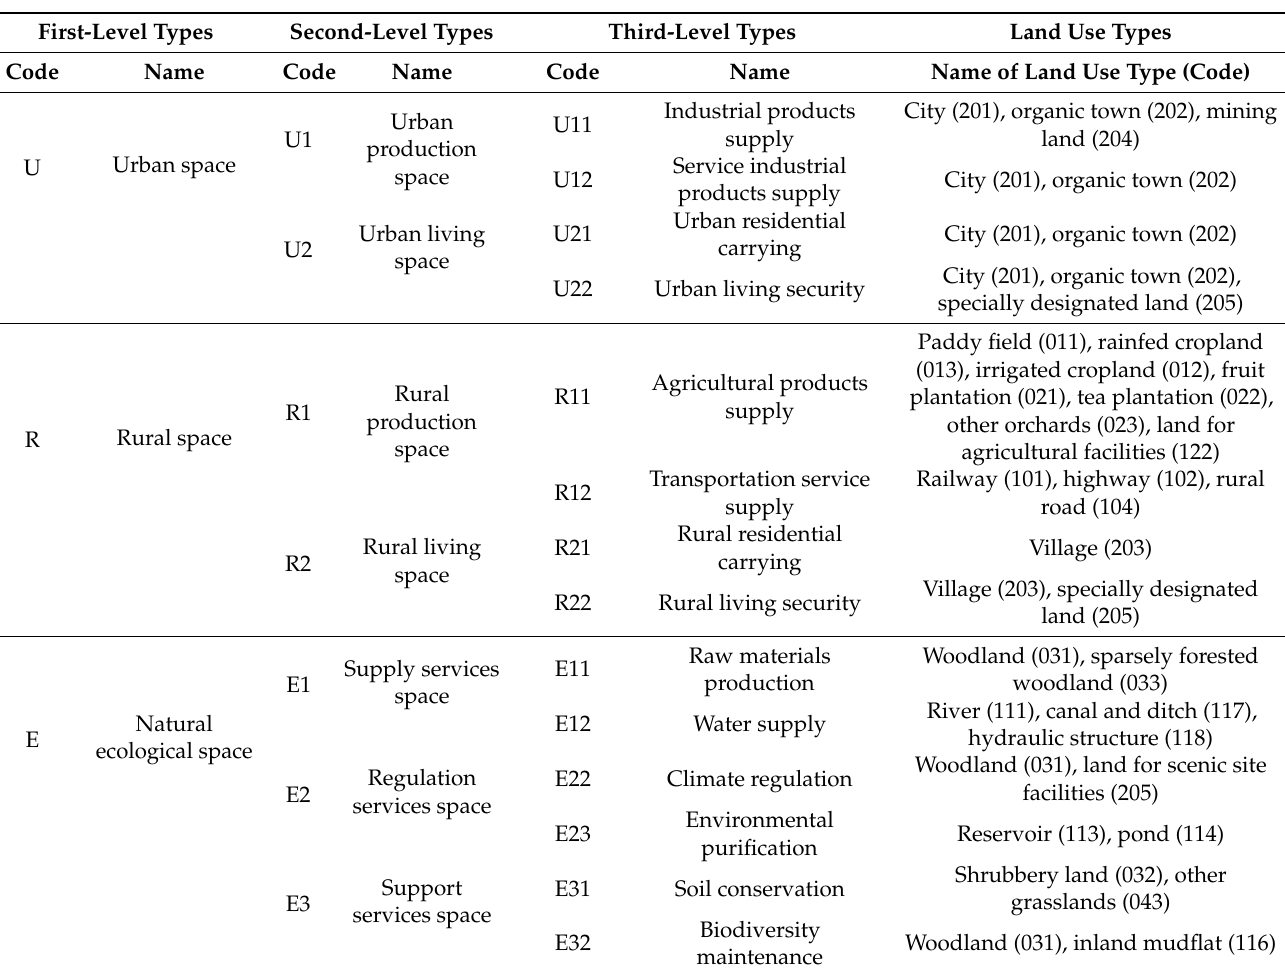
Table 5. TSC system in the city of